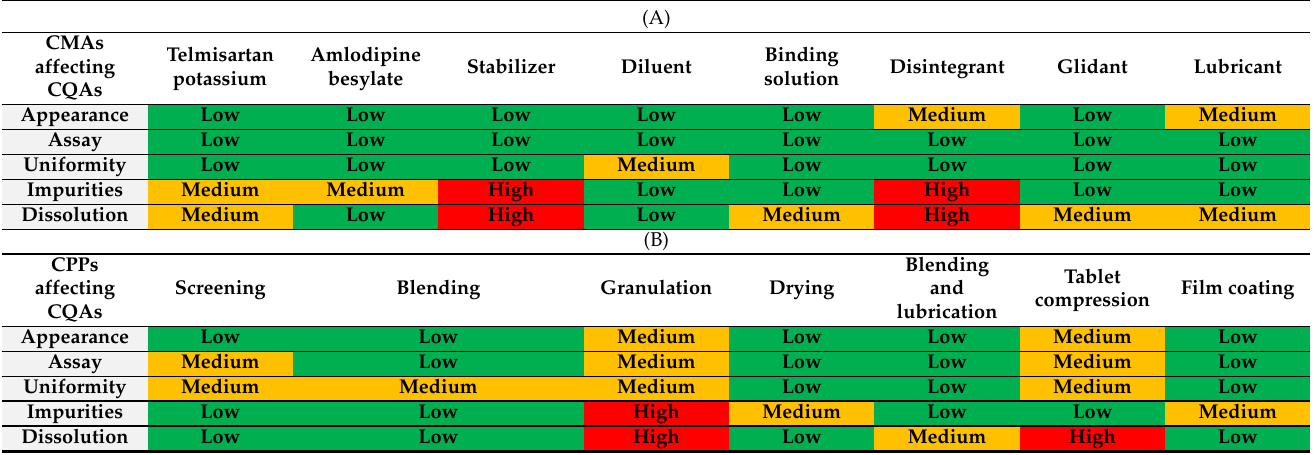
Table 2. Initial risk assessment of the critical material attributes (A) and critical process parameters (B) affecting critical quality